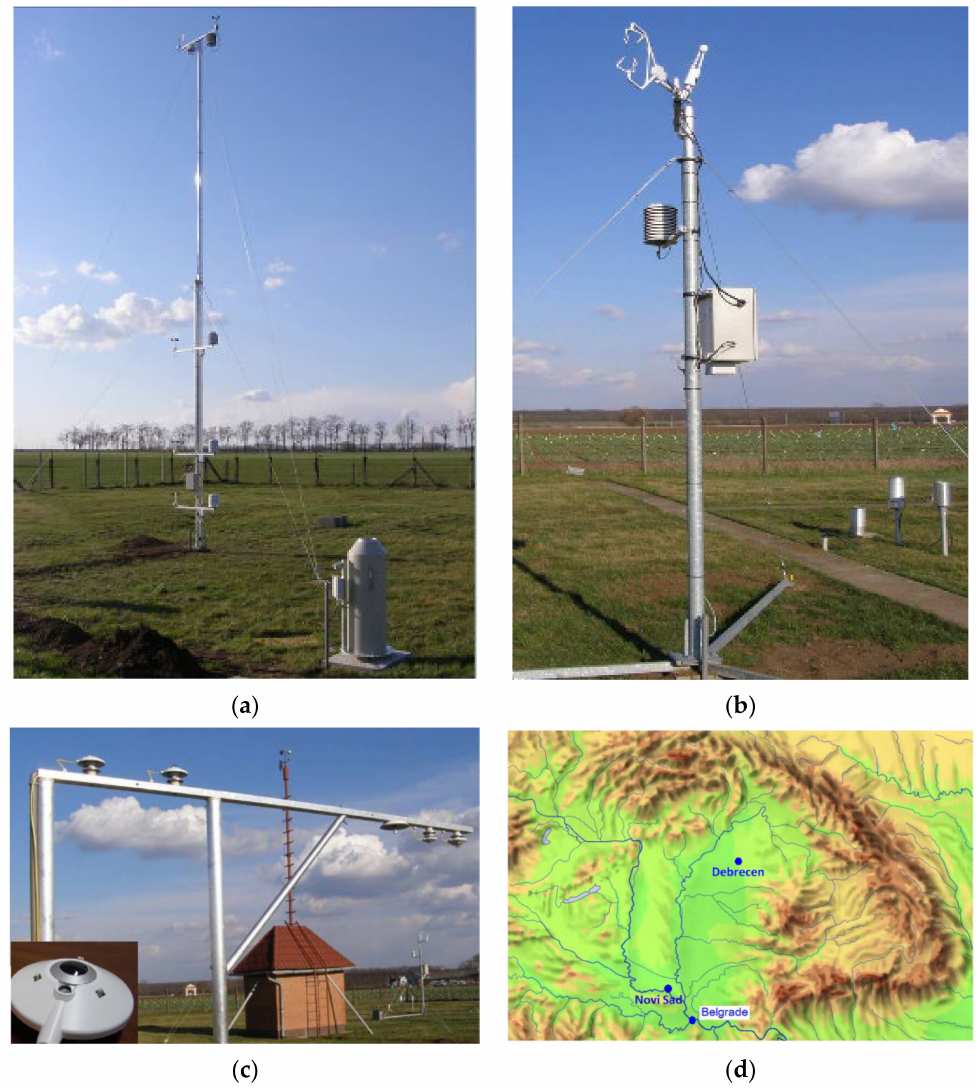
Figure 1. Micrometeorological (radiation, surface energy budget and profile) measurements in the Agrometeorological Observatory Debrecen. ( a ) Temperature, relative humidity and wind speed profile measurements on a 10-m tower; ( b ) Eddy covariance measurements on a 4-m tower; ( c ) radia- tion balance components and surface temperature measurements with WMO first class instruments (small photo with a Kipp&Zonen CGR4 pyrgeometer) and ( d ) Debrecen, Novi Sad and Belgrade locations in the Pannonian